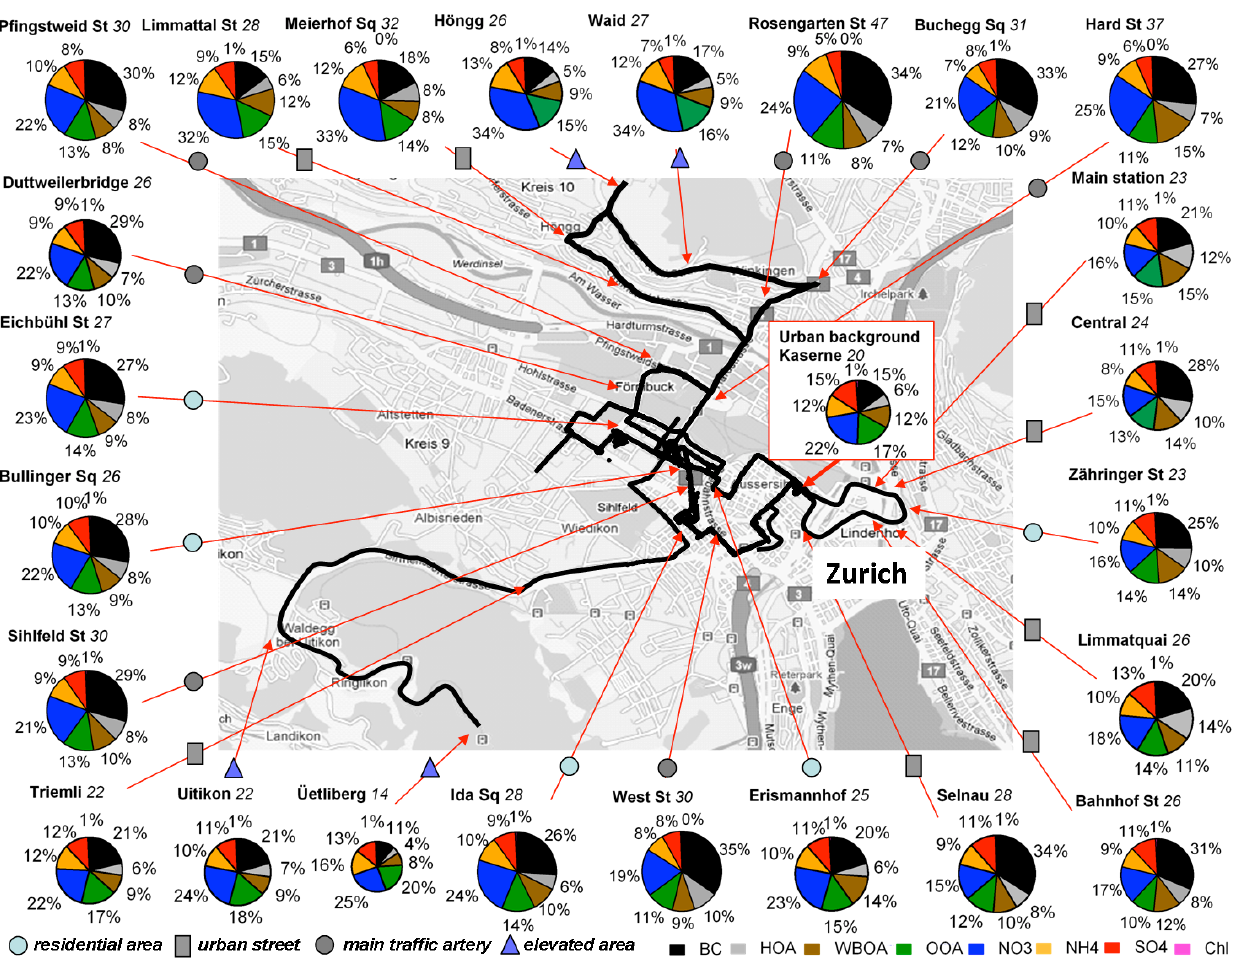
Fig. 6. Spatial variation of the PM 1 chemical composition as measured by Q-AMS and MAAP, PMF results included, in the area of Zurich city. Pie areas are relative to total average concentrations from all measurements, absolute concentrations are given in µgm − 3 (numbers in italics behind site names). Sites are categorized according to residential areas, urban streets, main traffic arteries, and elevated areas.